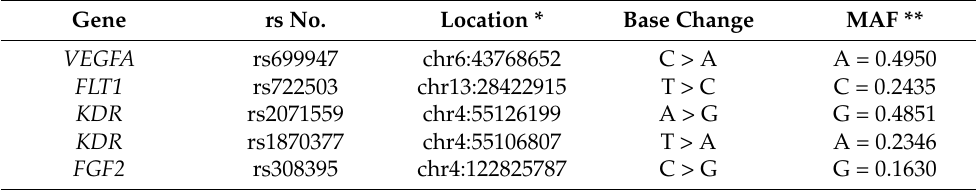
Table 7. Primary information of genotyped SNPs.